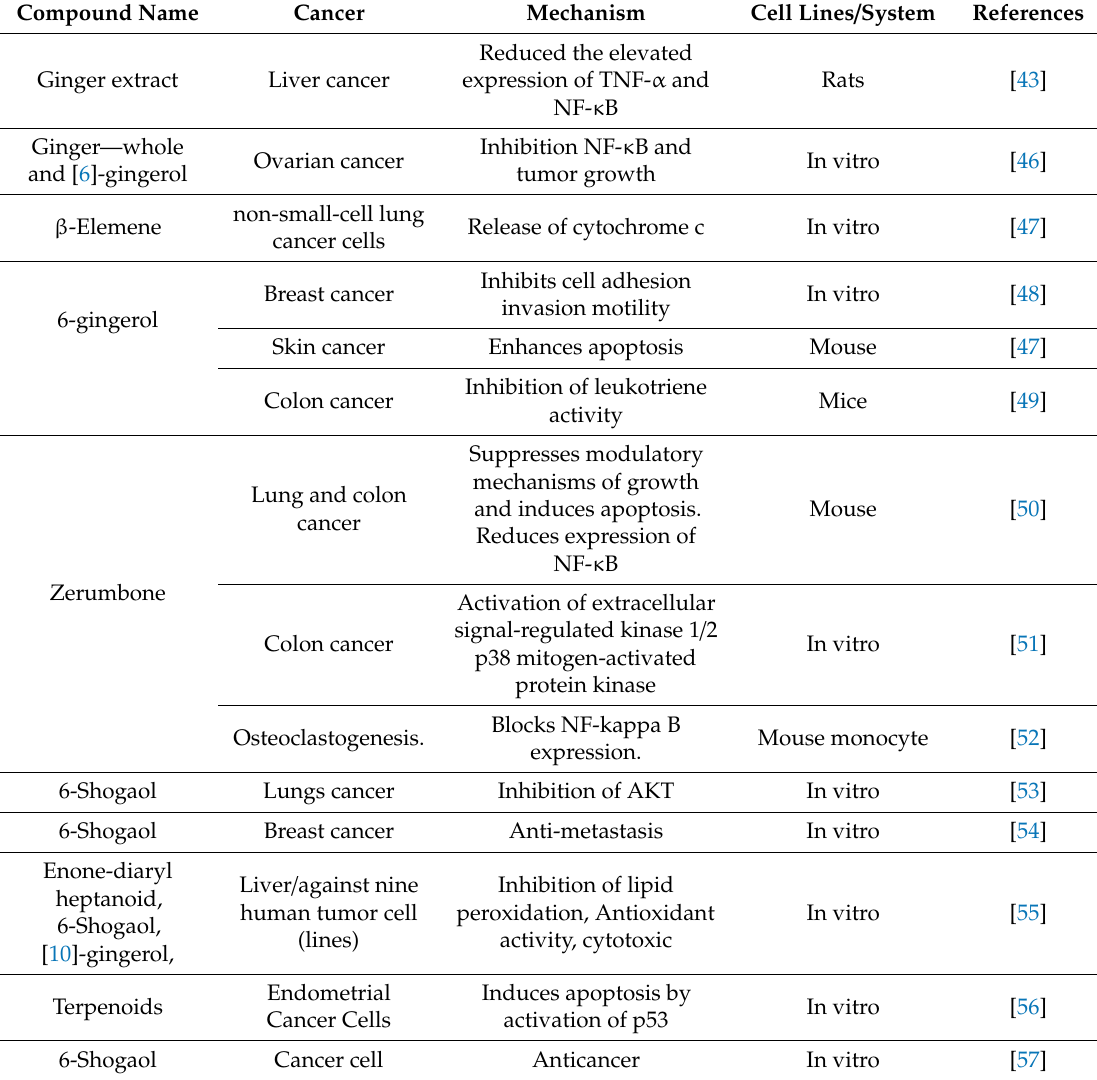
Table 4. Anticancer activity of